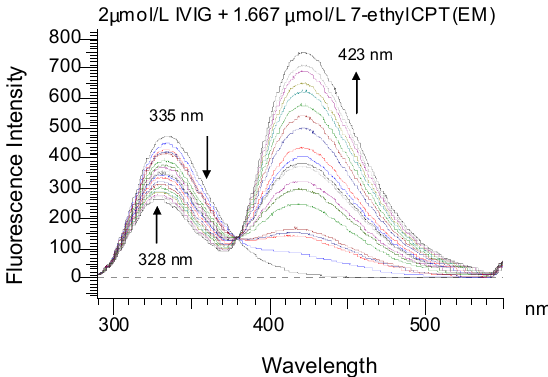
Figure 1. Fluorescence spectra of IVIG of 2.0 µ M free (the top spectrum at 335 nm) titrated by successive addition of 7-ethylcamptothecin solution (1.667 µ M) to give a final concentration of 33.33 µ M (the bottom spectrum at 328 nm) with the interval of successive addition by 5 min; λ ex = 280 nm, λ em = 335 nm; pH 4.0 and 310 K.